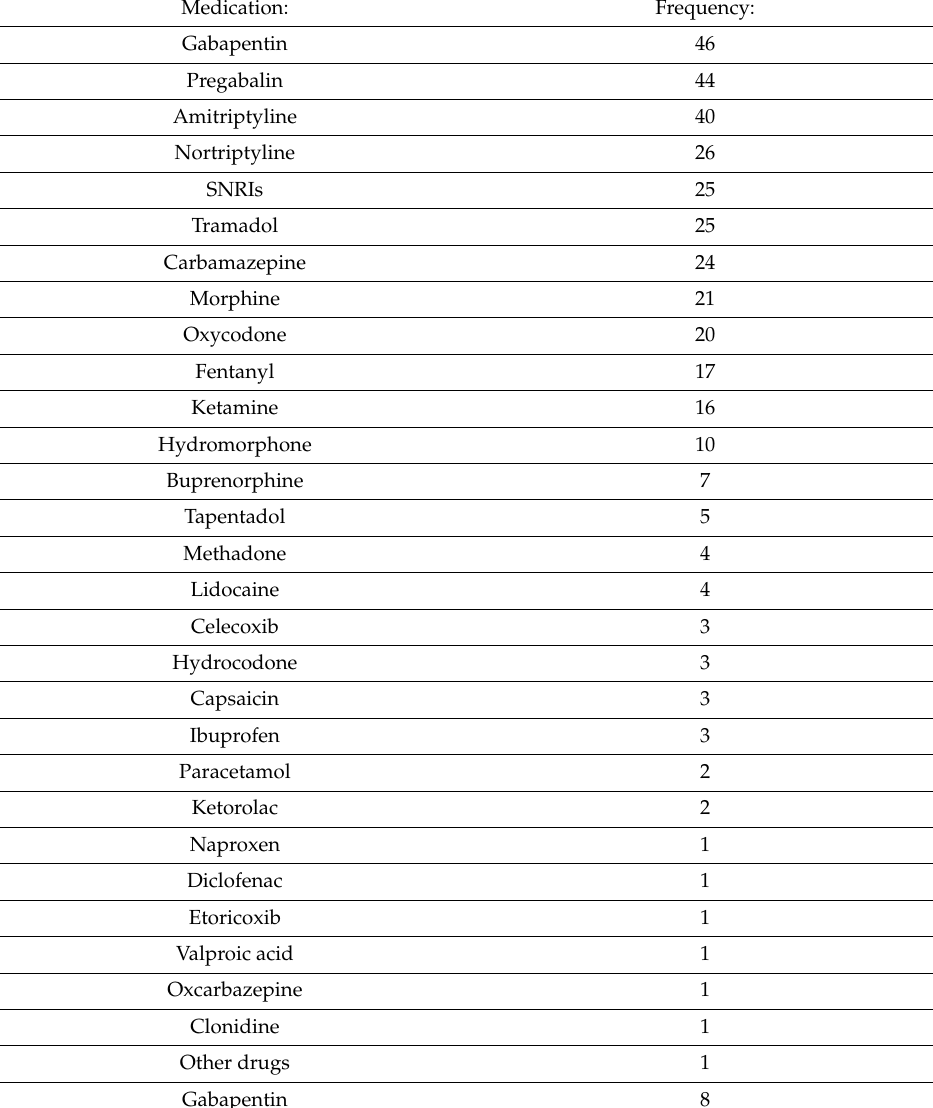
Table 7. Frequency at which practitioners titrate